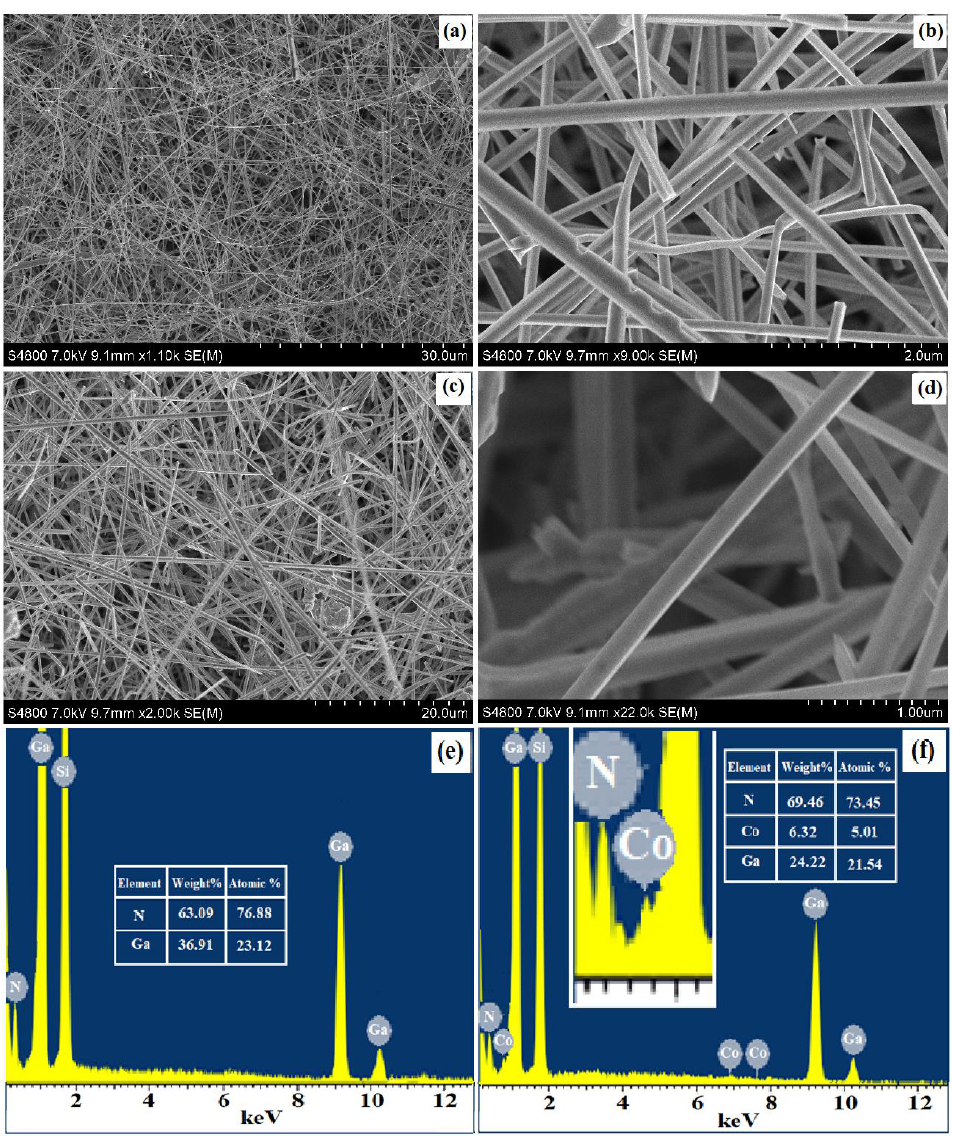
Figure 3. SEM micrographs of ( a ) pure GaN nanowires, ( b ) their magnified image, ( c ) 6% cobalt doped GaN nanowires and ( d ) 6% cobalt doped GaN nanowires magnified image. Also ( e ) and ( f ) are